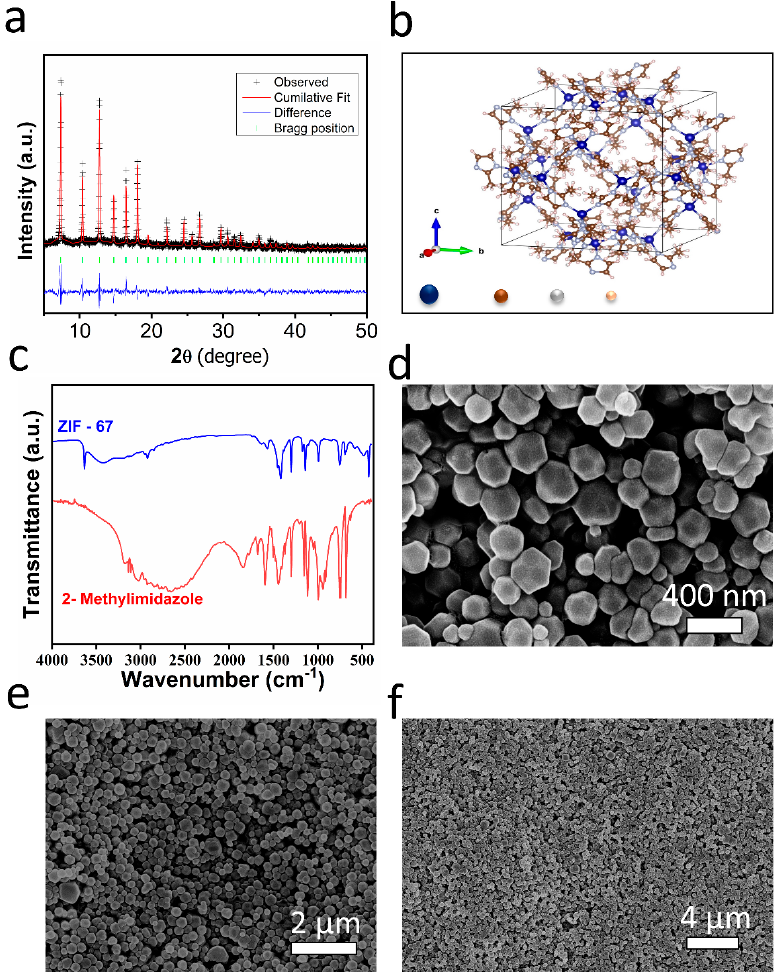
Figure 2 . ( a ) XRD studies of ZIF-67 and Rietveld refinement analysis, ( b ) simulated ZIF-67 structure, ( c ) FTIR spectrum of ZIF-67 crystal, and ( d – f ) SEM images of synthesized ZIF-67 at high and low magnifications.